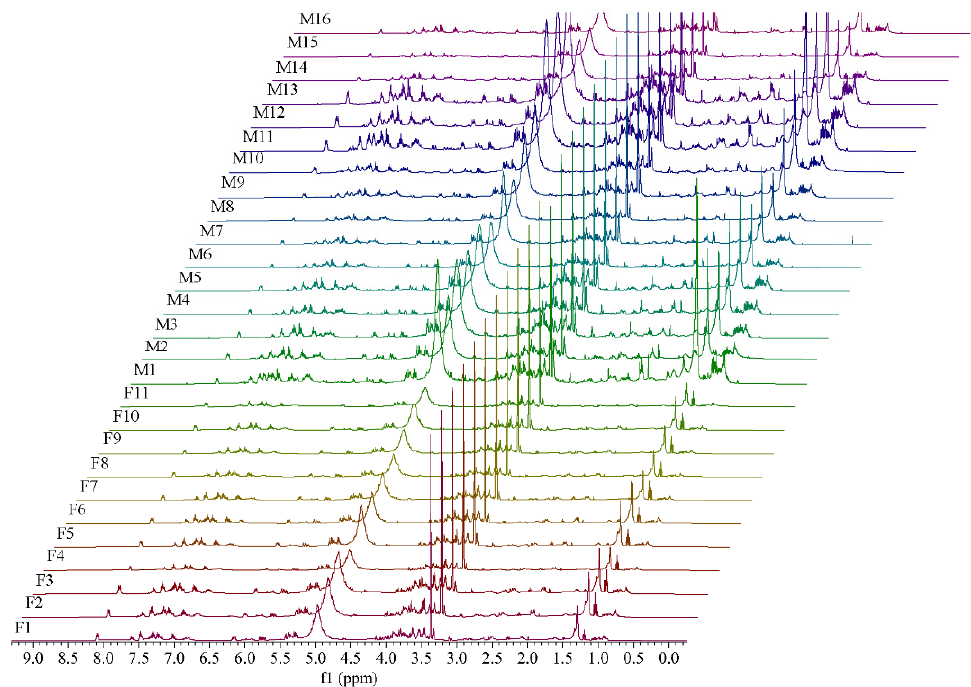
Figure 1. 1 H NMR spectra of 11 female and 16 male flower buds of P. tomentosa with the same amplification degree.